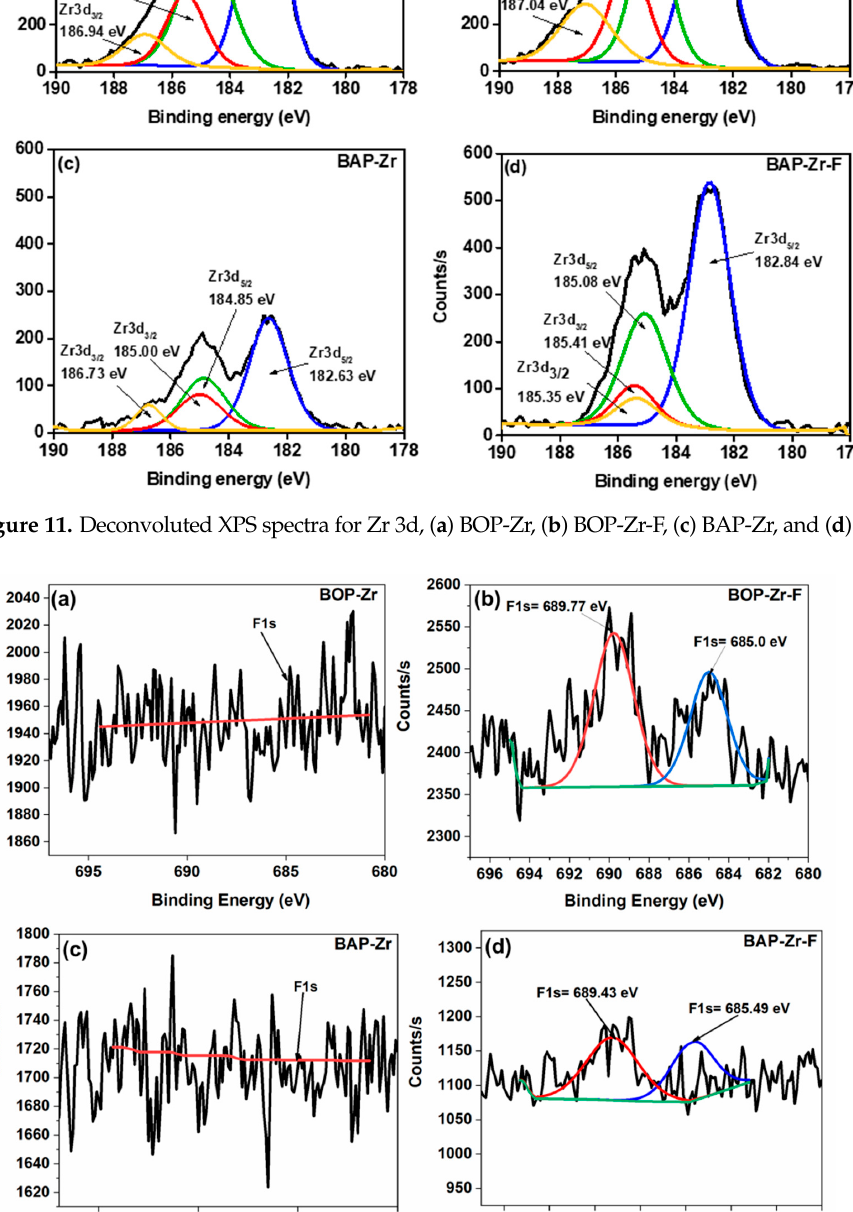
Figure 12. Deconvoluted XPS spectra for F1s: ( a ) BOP-Zr, ( b ) BOP-Zr-F, ( c ) BAP-Zr, and ( d ) BAP-Zr-F.